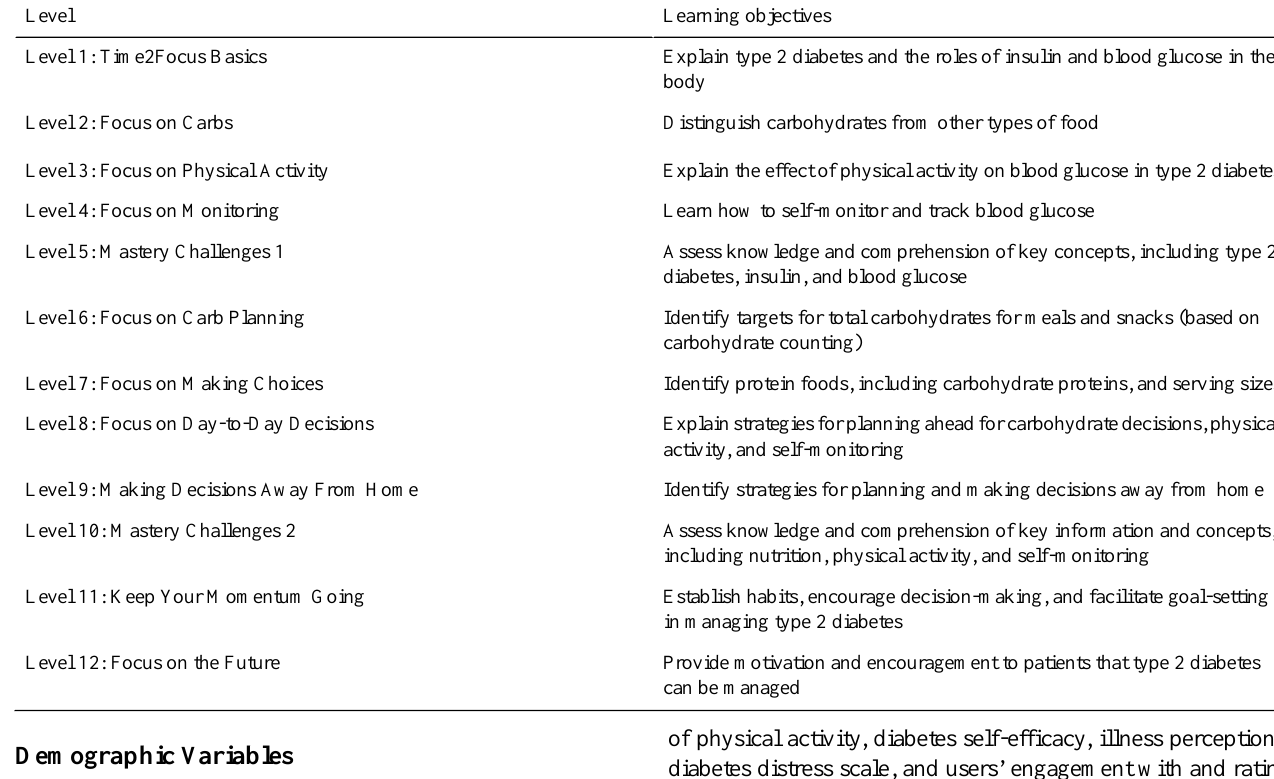
Table 1. Summary of level learning objectives.